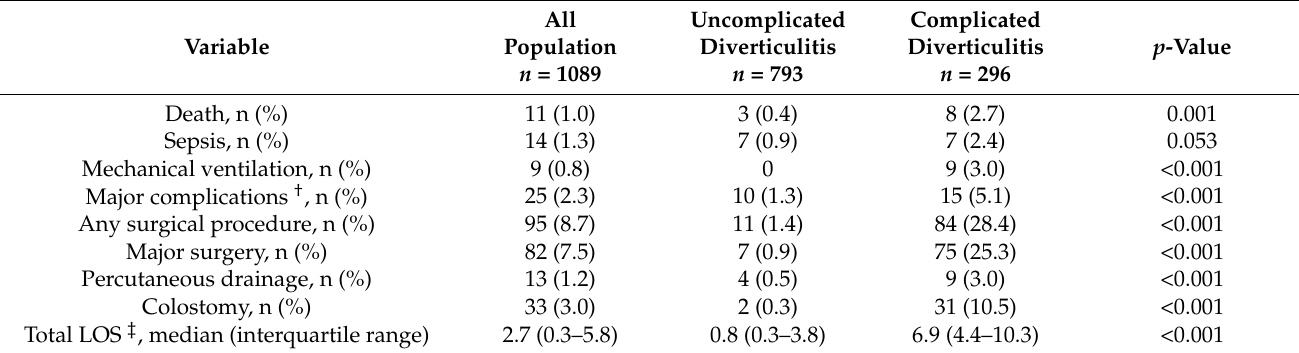
Table 3. Comparison of patient outcomes between complicated and uncomplicated diverticulitis.